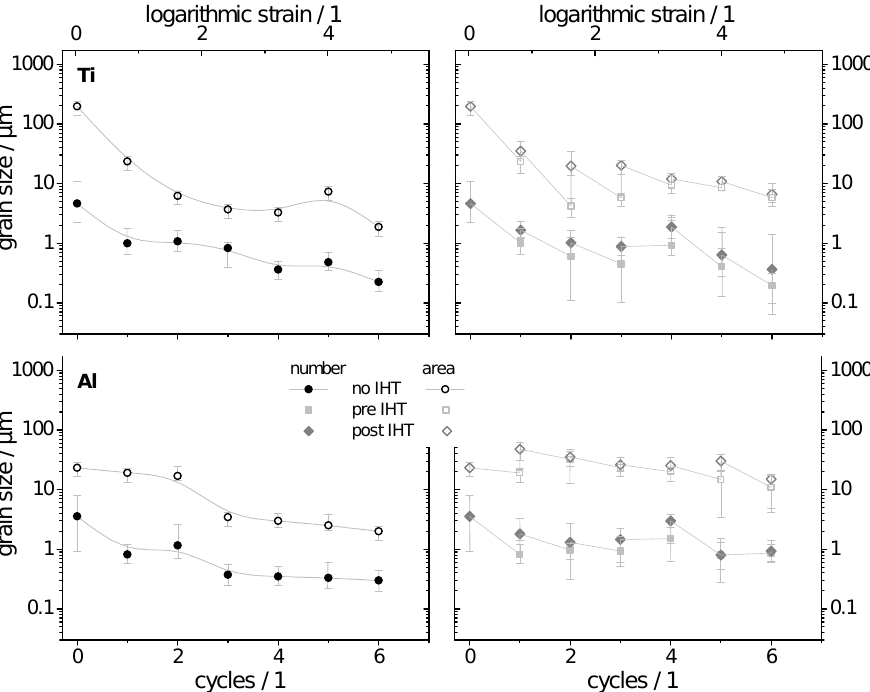
Figure 5. Grain size within the Ti (upper row) and Al layers (lower row) after ARB at room temperature (left), as well as with IHTs applied (right). In the latter case, the grain sizes are provided after the ARB cycles before (pre-IHT) and after IHT (post-IHT). The grain sizes were evaluated by both number and area weighting.